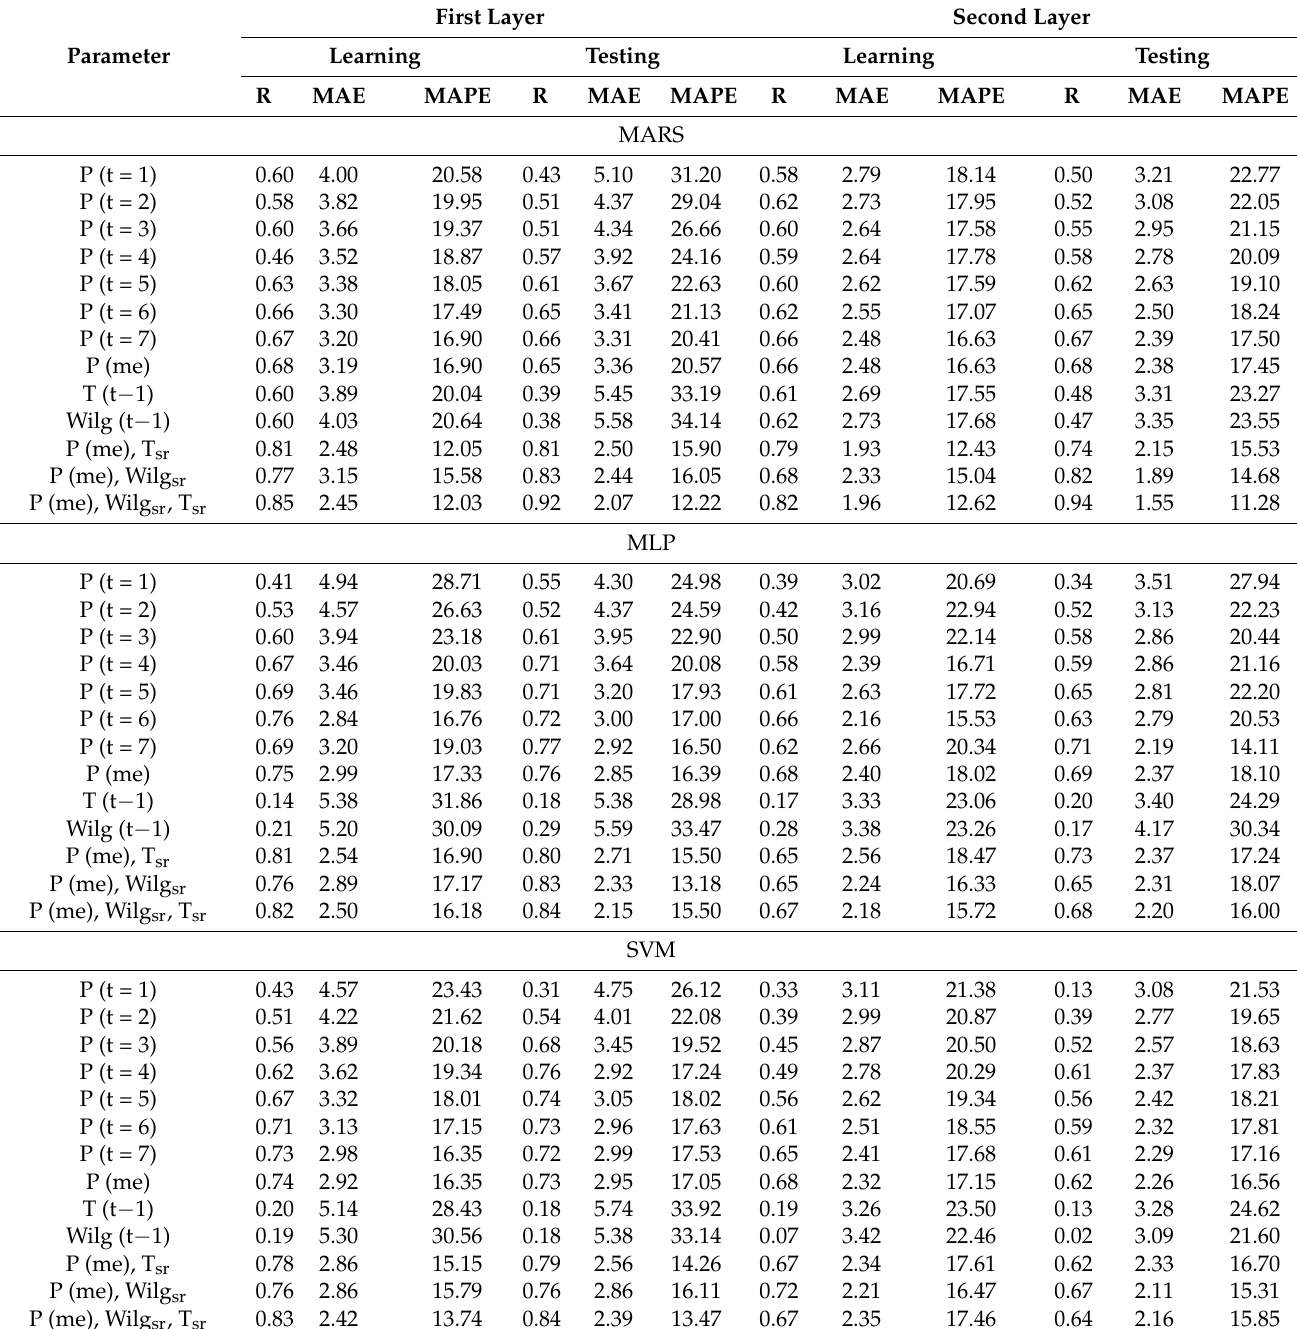
Table 3. Comparison of predictive capabilities for MARS, SVM, MLP